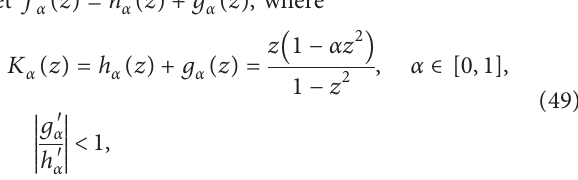
Figure 3: Image of P